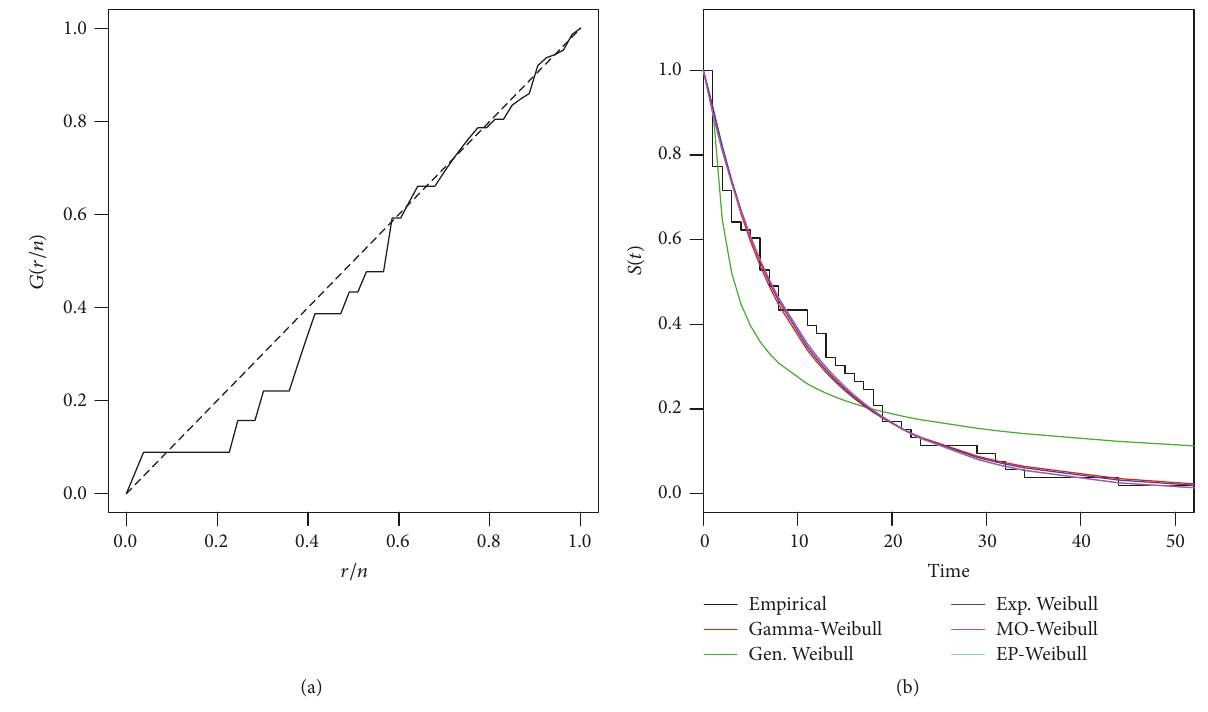
Figure 4: Transmission A empirical (a) TTT-plot, and (b) contains the fitted survival superimposed to the empirical survival function and the hazard function adjusted by distribution.